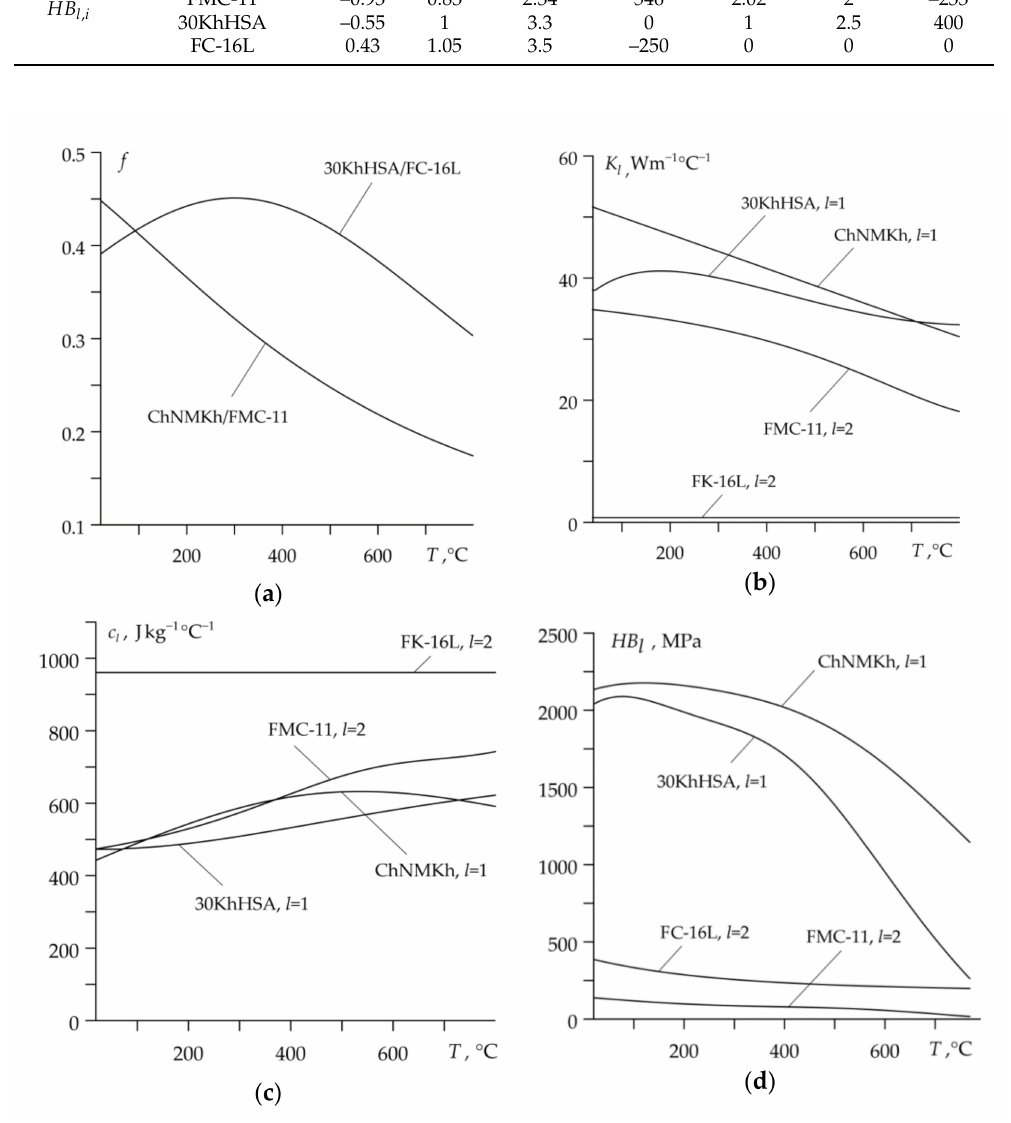
Figure 3. Graphs of functions approximating the experimental data of the dependence on tempera- ture: ( a ) coefficient of friction f ; ( b ) thermal conductivity K l ; ( c ) specific heat capacity c l ; ( d ) Brinell hardness HB l , l =